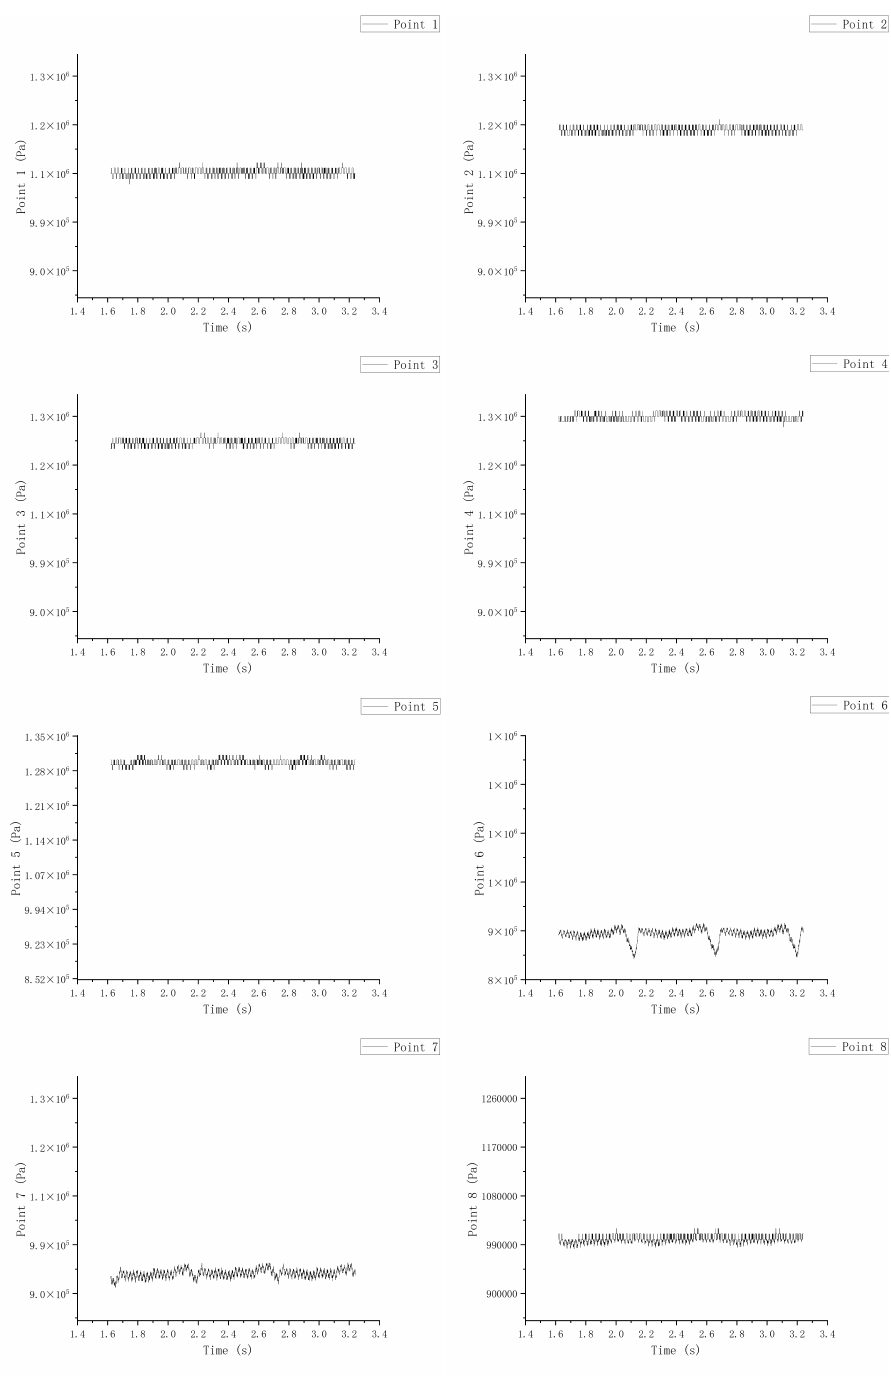
Figure 21. The pressure distributions of the upper